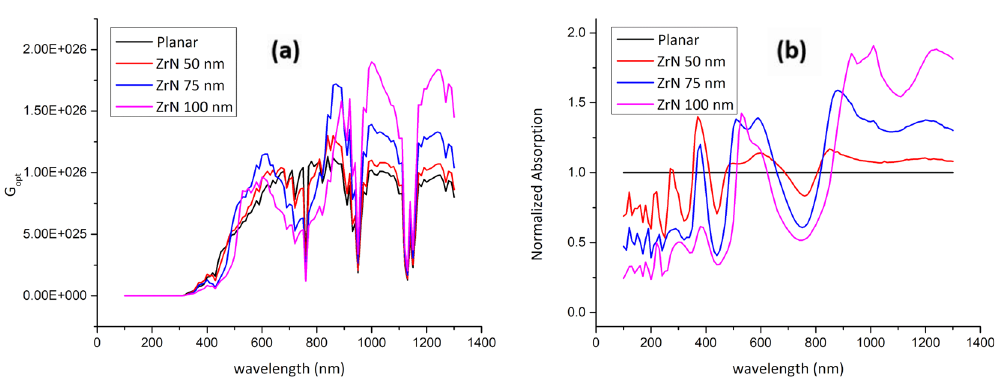
Figure 7. ( a ) Optical carrier generation rate ( G opt ) and ( b ) normalized light absorption profiles for planar and ZrN-decorated PSCs.